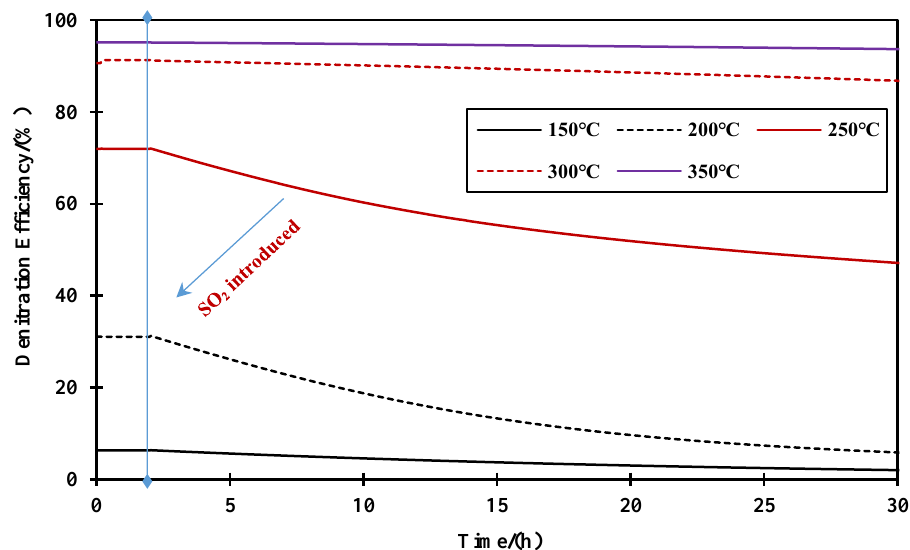
Figure 15. The variation law of the denitration efficiency with time under the condition of sulfur-containing exhaust gas.